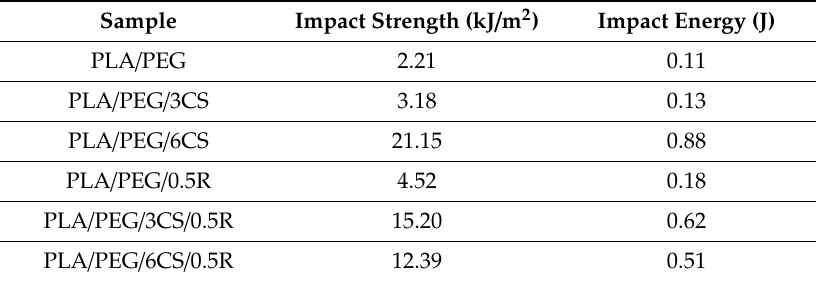
Table 4. Impact properties of the plasticized PLA-based biocomposites containing chitosan and alcoholic rosemary